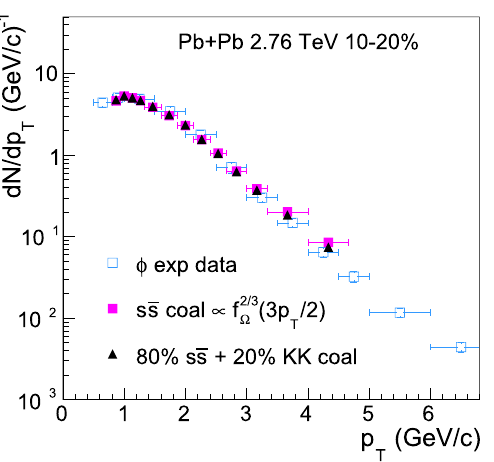
Fig. 11 The p T spectrum of φ calculated by pure s ¯ s combination and that by mixture of s ¯ s combination and K K coalescence in Pb+Pb colli- √ s NN = sionsat